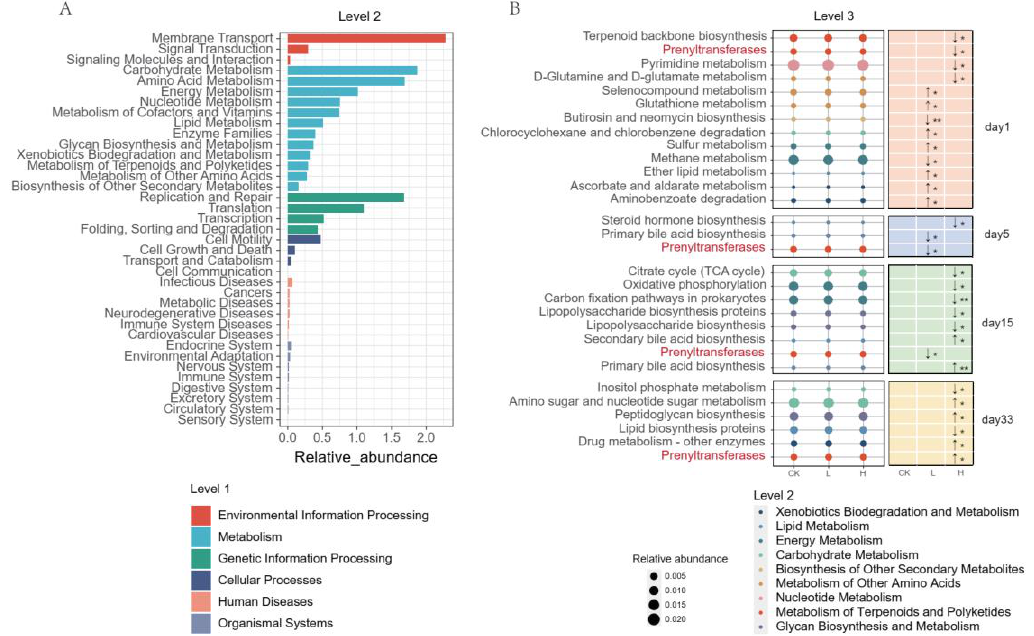
Figure 6. The relative abundance of KEGG level 1, level 2, and level 3 pathways in the three groups according to PICRUSt2 function prediction. ( A ) The bar plot was generated with the relative abundances of all the level 2 pathways, and different colors represent different level 1 metabolic pathways. ( B ) Bubble plots based on the relative abundance of significantly different level 3 metabolic pathways in different groups at different days ( p < 0.05). The size of the bubble represents the relative abundance of pathways, while the color indicates the level 2 pathway to which it belongs. The prenyltransferases pathway was marked red text colour. The symbol * indicates that the relative abundance of the level 3 pathway in this group was significantly downregulated ( ↓ ) or upregulated ( ↑ ) when compared with that in group CK (* represents p < 0.05, ** represents p < 0.01).